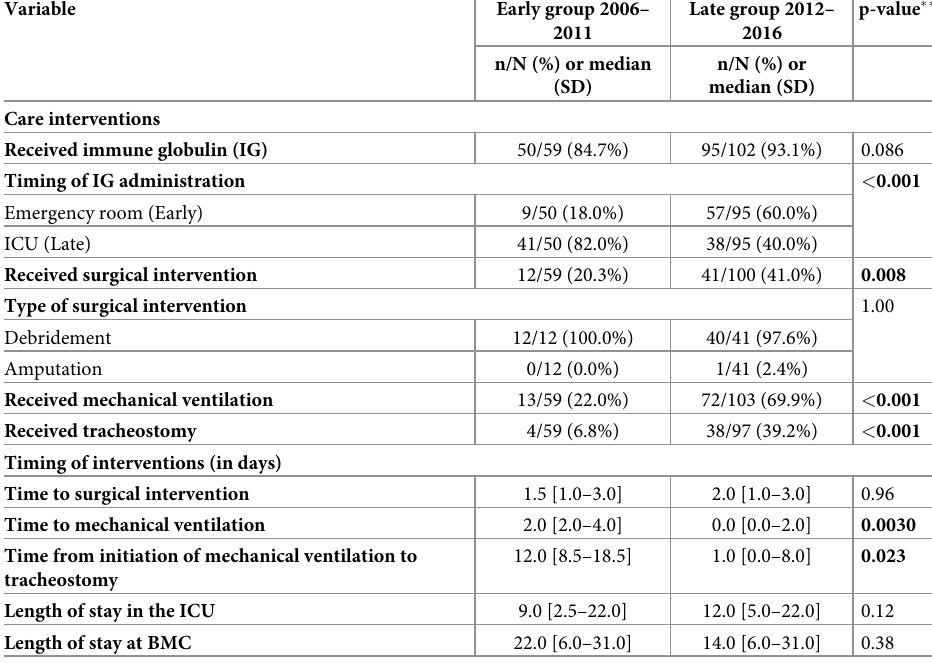
Table 2. Care interventions done as per protocol for the early (2006–2011) and the late group (2012–2016) (cid:3) .